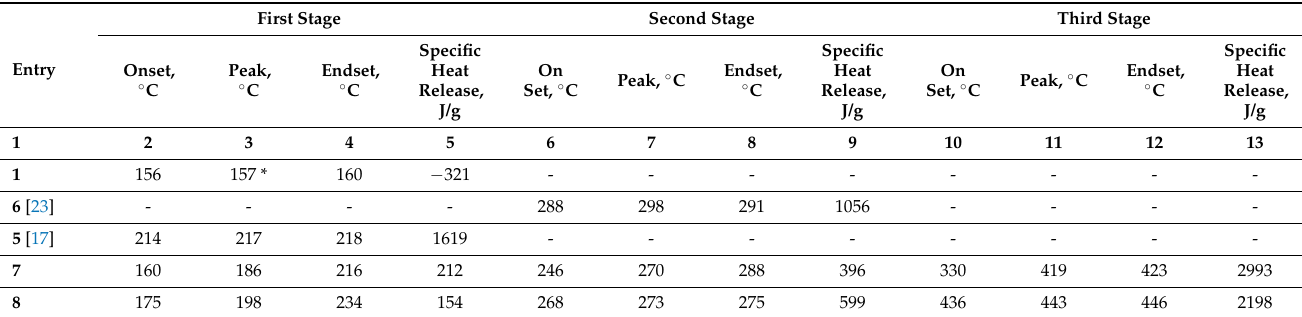
Table 2. DSC data on decomposition temperatures of 1 , 5 , 6 , 7 and 8 .